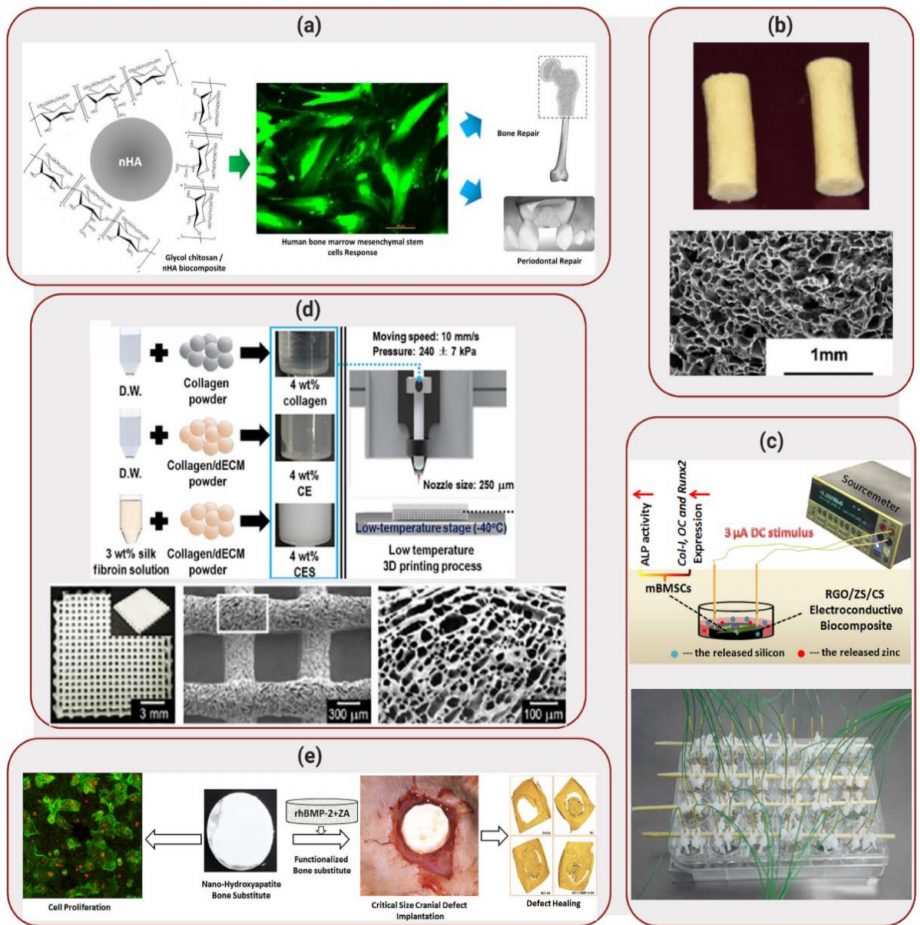
Figure 2. Applications of Biocomposites to Bone Regeneration: ( a ) Synthesis of glycol